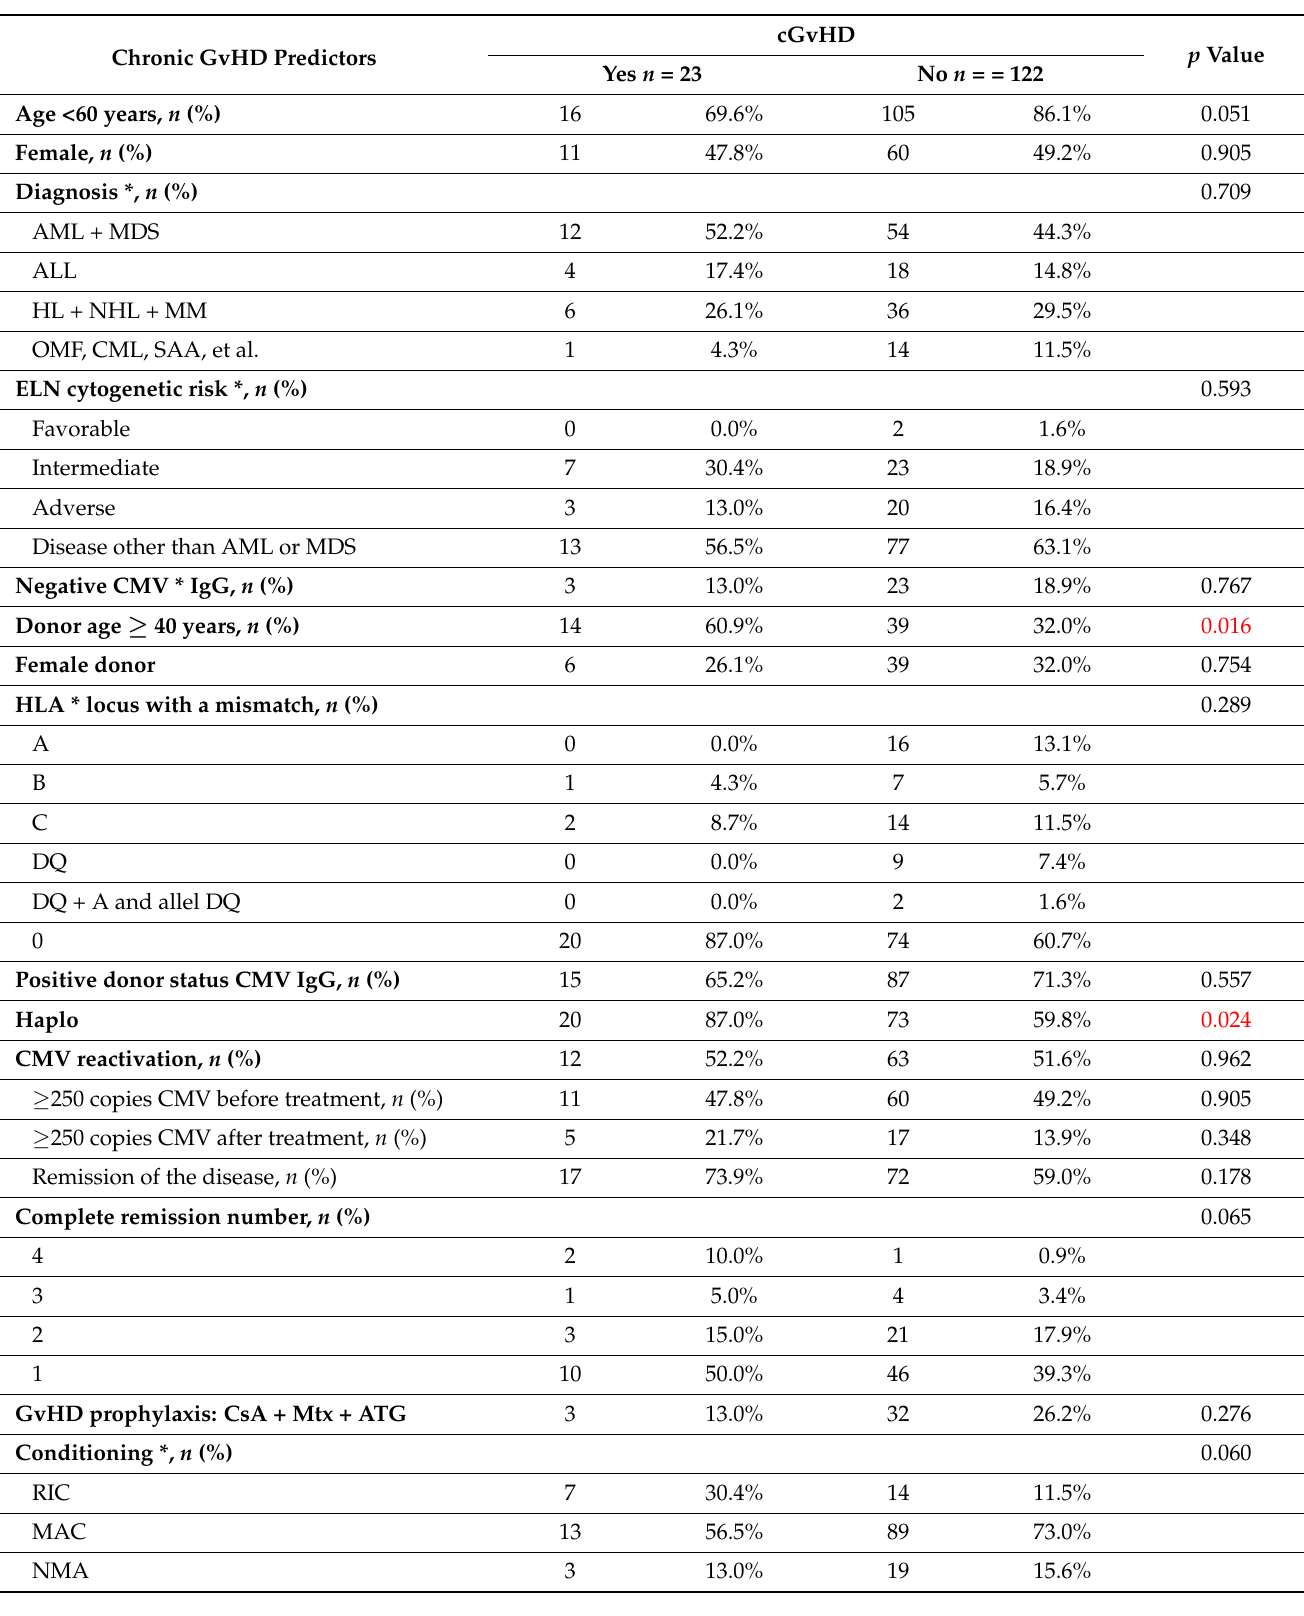
Table 4. The characteristics of patients differing by the presence of chronic GvHD in a study popula- tion (in red: p <